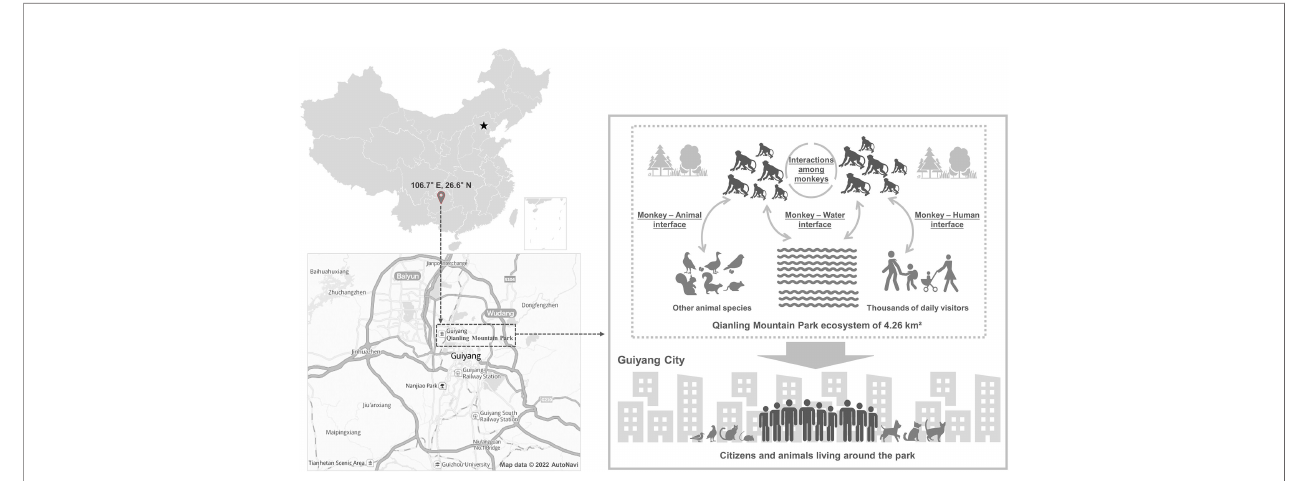
FIGURE 3 | Schematic overview of the location and ecosystem of Qianling Mountain Park, main One Health interfaces, and potential public health implications. The star symbol represents Beijing city, the capital of